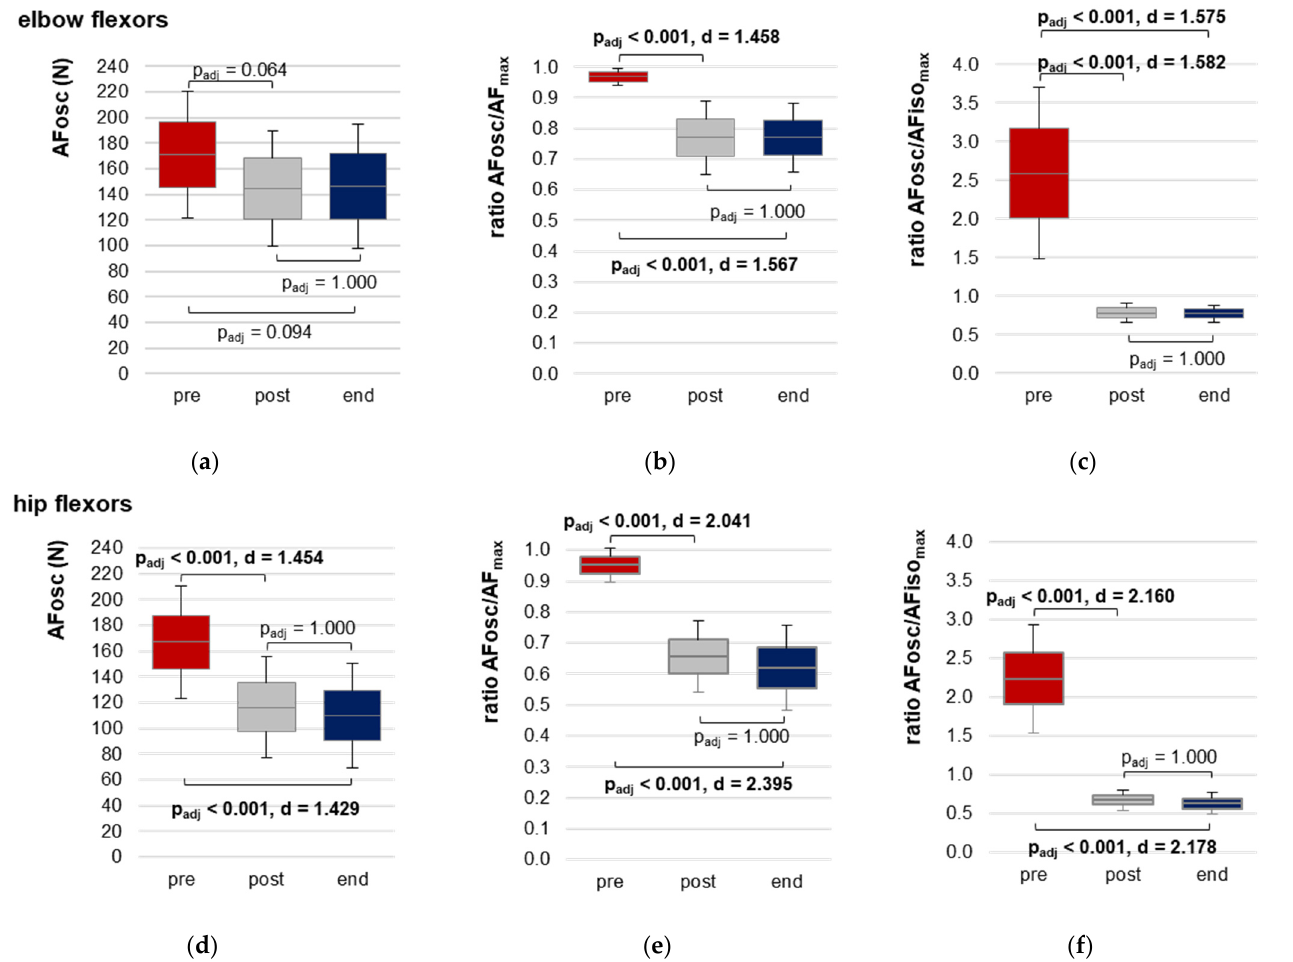
Figure 5. Adaptive Force at onset of oscillations. Displayed are the arithmetic means, standard deviations (error bars) and 95% CIs of AF parameters with regard to the onset of oscillations during MMT for both muscles at each time point: pre (red), post (grey) and end (blue). Elbow flexors: ( a ) AF at onset of oscillations (AFosc); ( b ) ratio of AFosc to AF max and ( c ) ratio of AFosc to AFiso max ; hip flexors: ( d ) AFosc; ( e ) ratio of AFosc to AF max and ( f ) ratio of AFosc to AFiso max . Adjusted p -values (Bonferroni correction) and effect sizes Cohen’s d are given in case of significance.